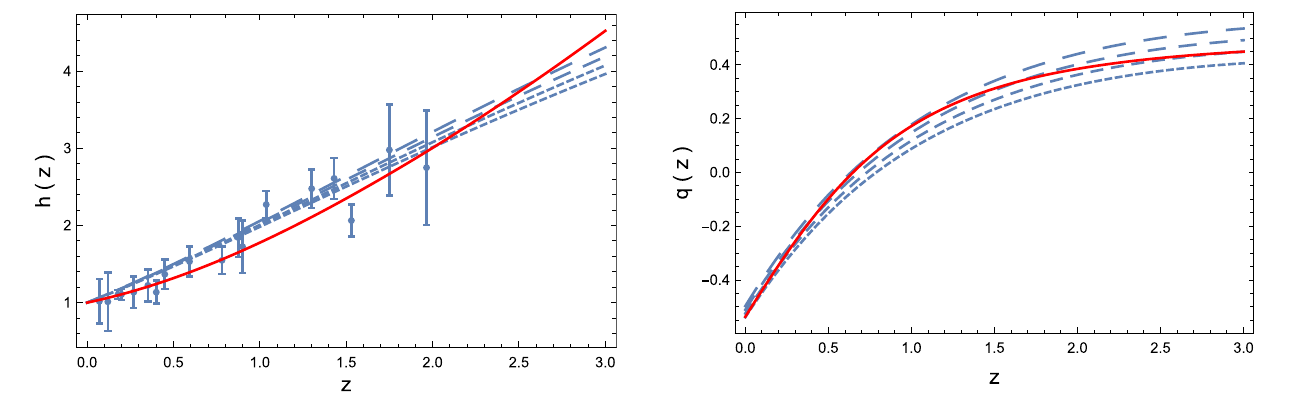
Fig. 2 Variation in the deceleration parameter q as a function of the redshift z for η( z ) = a 1 h n ( z ) + b 1 for n = 2 / 3, b 1 = − 0 . 21, c 1 = 3 . 9, anddifferentvaluesof a 1 : a 1 = 0 . 348,(shortdashedcurve), a 1 = 0 . 350 (dashed curve), a 1 = 0 . 352, (long dashed curve), and a 1 = 0 . 354, (ultra-long dashed curve), respectively. The red solid line represents the prediction of the (cid:2) CDM model